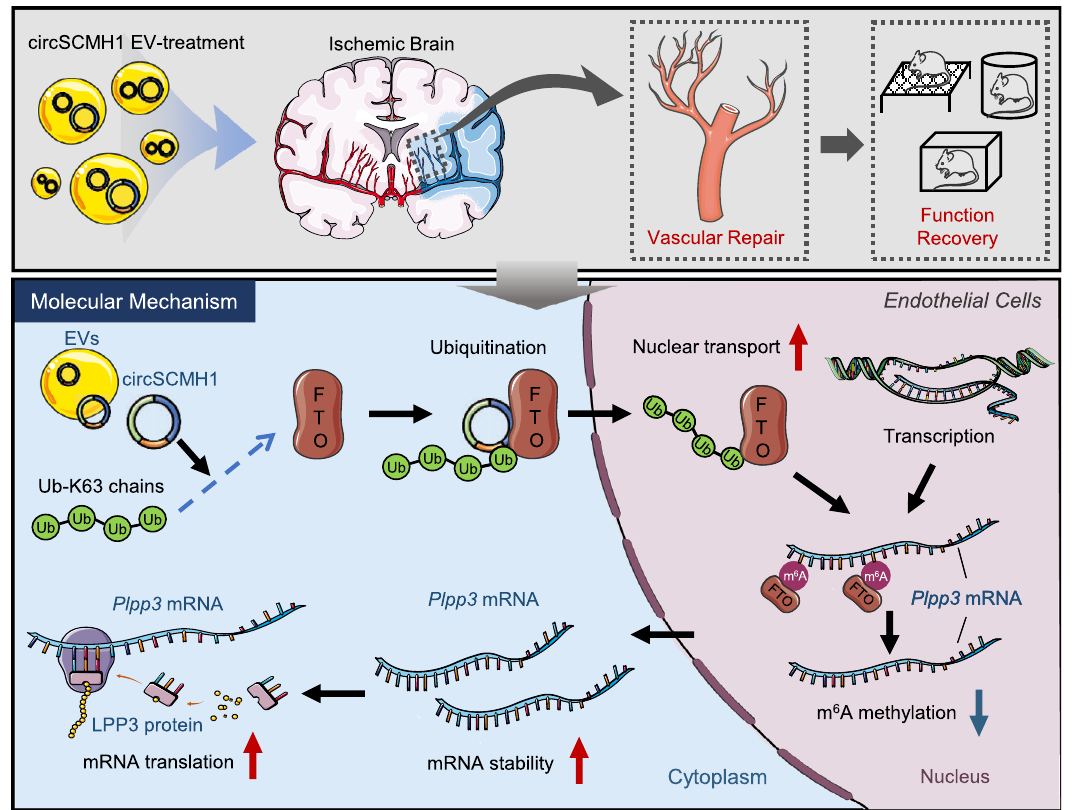
Fig. 8 | Schematic illustration of the enhancement effect of EV-circSCMH1 on vascular repair after ischemic stroke. Intravenous administration of EV- circSCMH1 after ischemic stroke signi fi cantly enhanced vascular repair in mouse and monkey models. The level of m 6 A was signi fi cantly increased in the somato- sensory cortex of AIS patients and the peri-infarct cortex of mouse stroke models. Endothelial-targeted FTO overexpression signi fi cantly improved functional recov- eryin miceby enhancement ofvascular repair. In ECs, circSCMH1 bound with